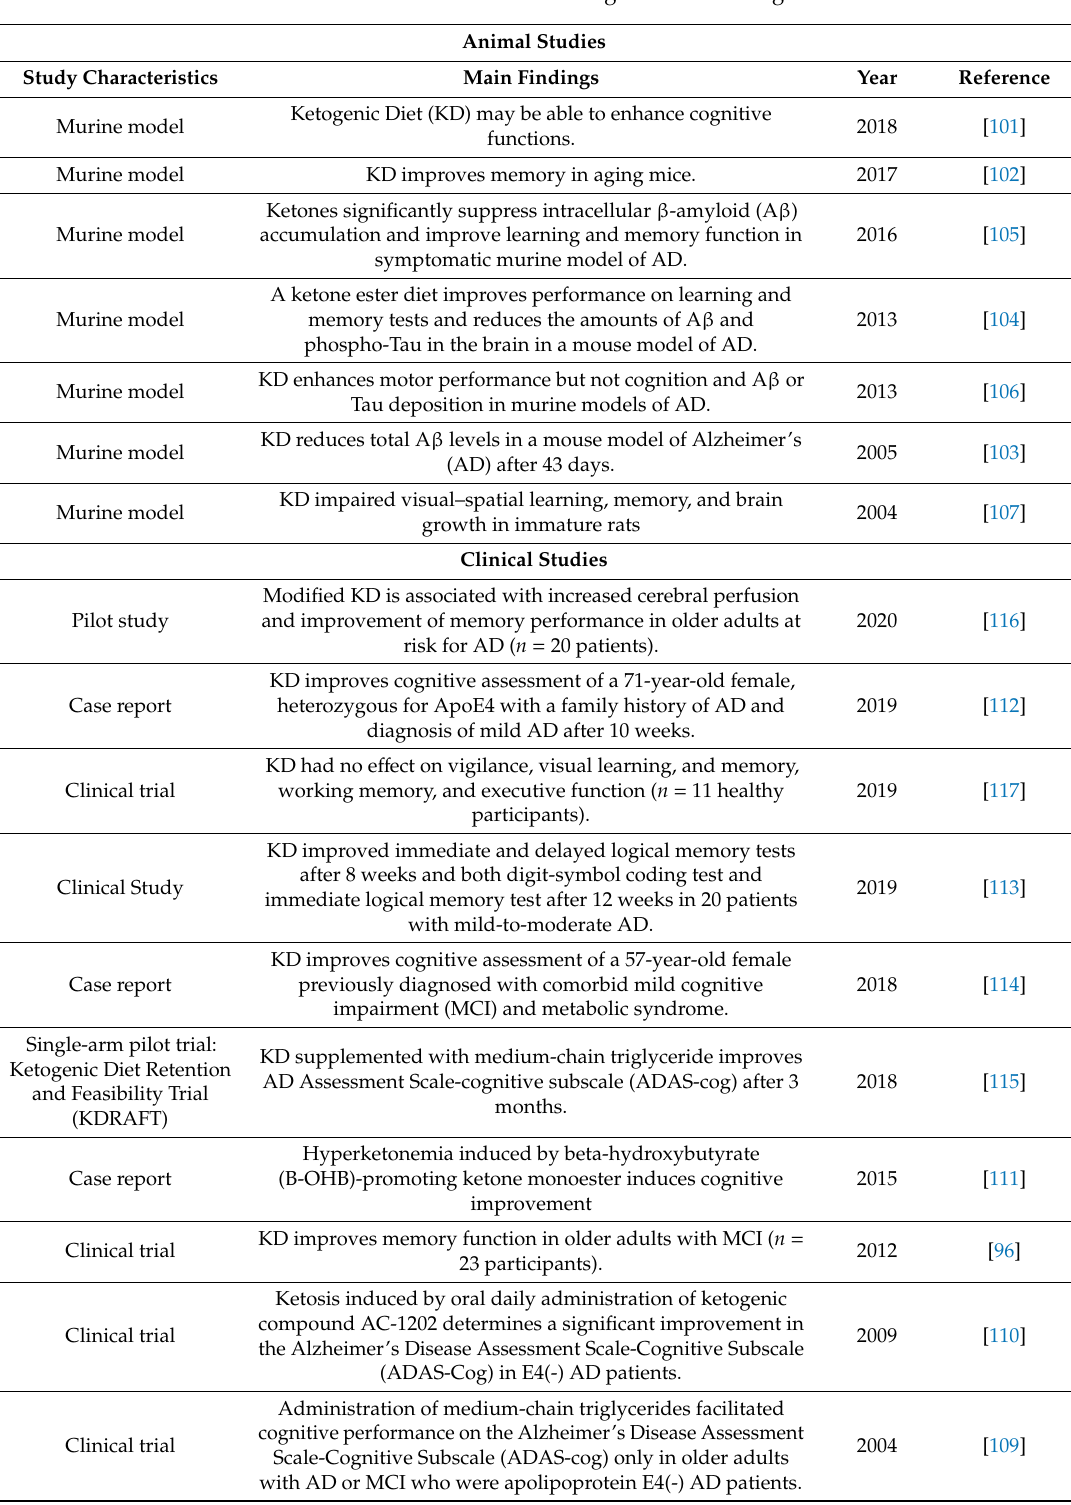
Table 3. Evidence on association between ketogenic diet and cognitive